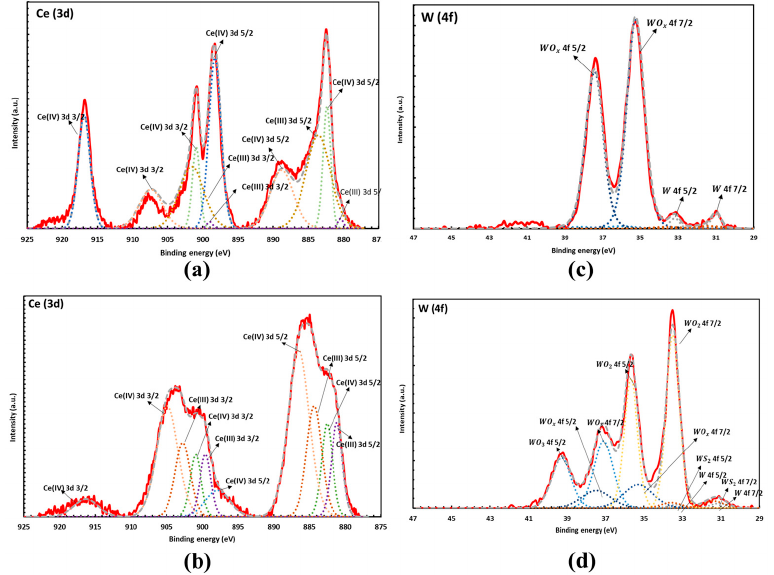
Figure 2. XPS spectra of pre-HIP sample in the Ce_3d region ( a ) and W_4f region ( c ). Post-HIP sample in the Ce_3d region ( b ) and W_4f region ( d ) showing the formation of mixed Ce 3+ and Ce 4+ after HIP. Peaks are labelled showing a combination of metallic and oxide peaks. The residual oxygen reacts with tungsten to form tungsten oxide during HIP.